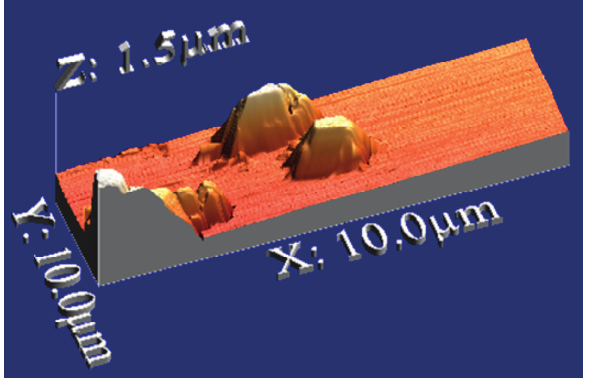
Figure 9. Surface characterization of Bacillus subtilis spores by atomic force microscopy in contact